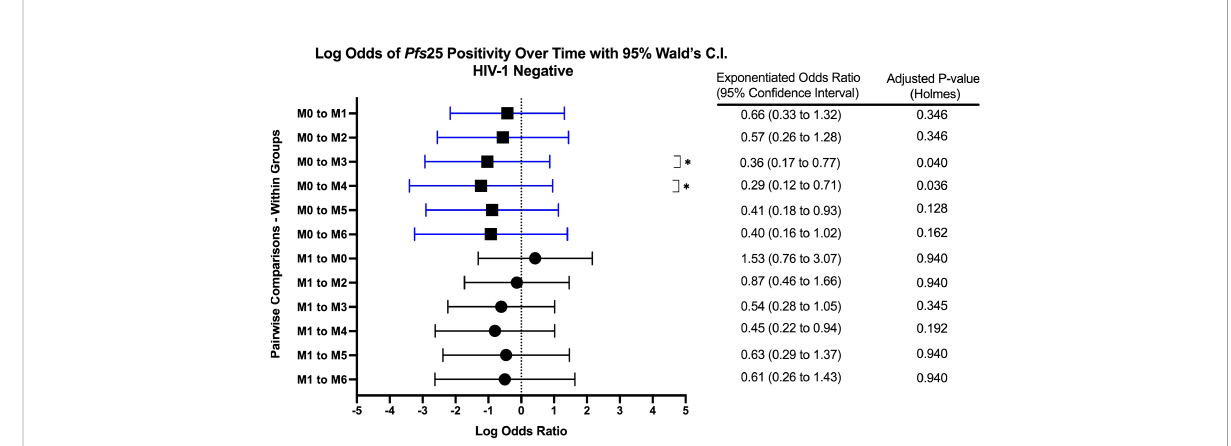
FIGURE 6 Forest Plot of the Log Odds of Pfs25 Positivity in HIV-1 Negative Volunteers. The log odds and accompanying exponentiated adjusted odds ratio of being positive for at least one gametocyte-speci fi c transcript within the HIV-1 negative study group between month 0 (M0) and between month 1 (M1). P-values were adjusted using the Holm ’ s method for multiple comparisons. Blue con fi dence interval lines are comparisons with month 0 and black con fi dence interval lines are comparisons with month